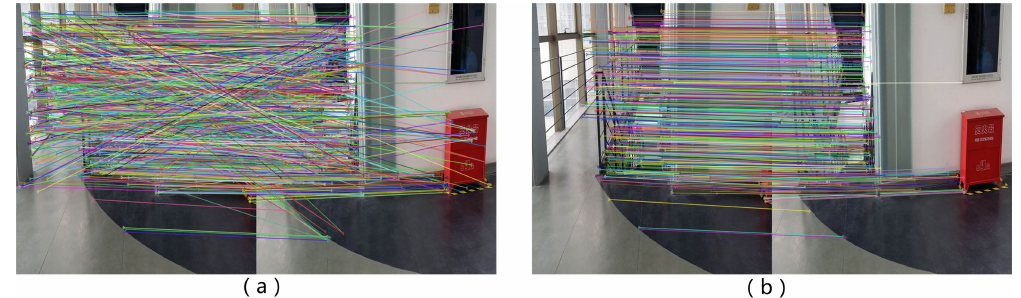
Figure 2. The matching results of SIFT and the multi-constrained algorithm. ( a ) the matching result of the SIFT method; ( b ) the matching result of the proposed